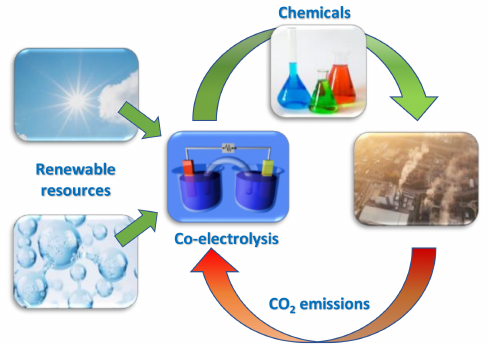
Figure 1. Scheme of the electrochemical CO 2 capture and conversion to chemicals as a carbon neu- tral